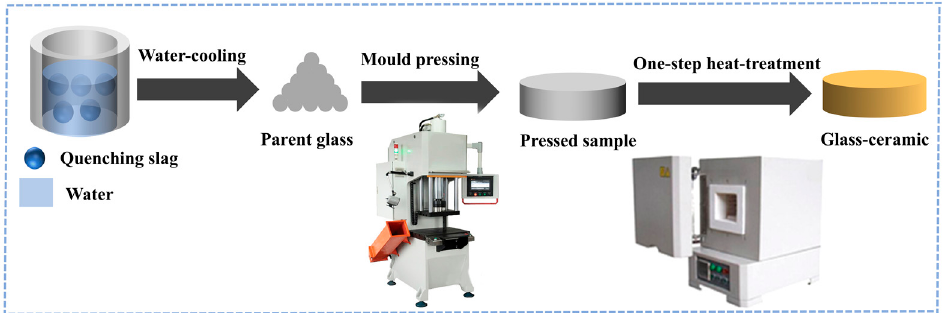
Figure 1. Schematic of the preparation of microcrystalline glass through one-step heat